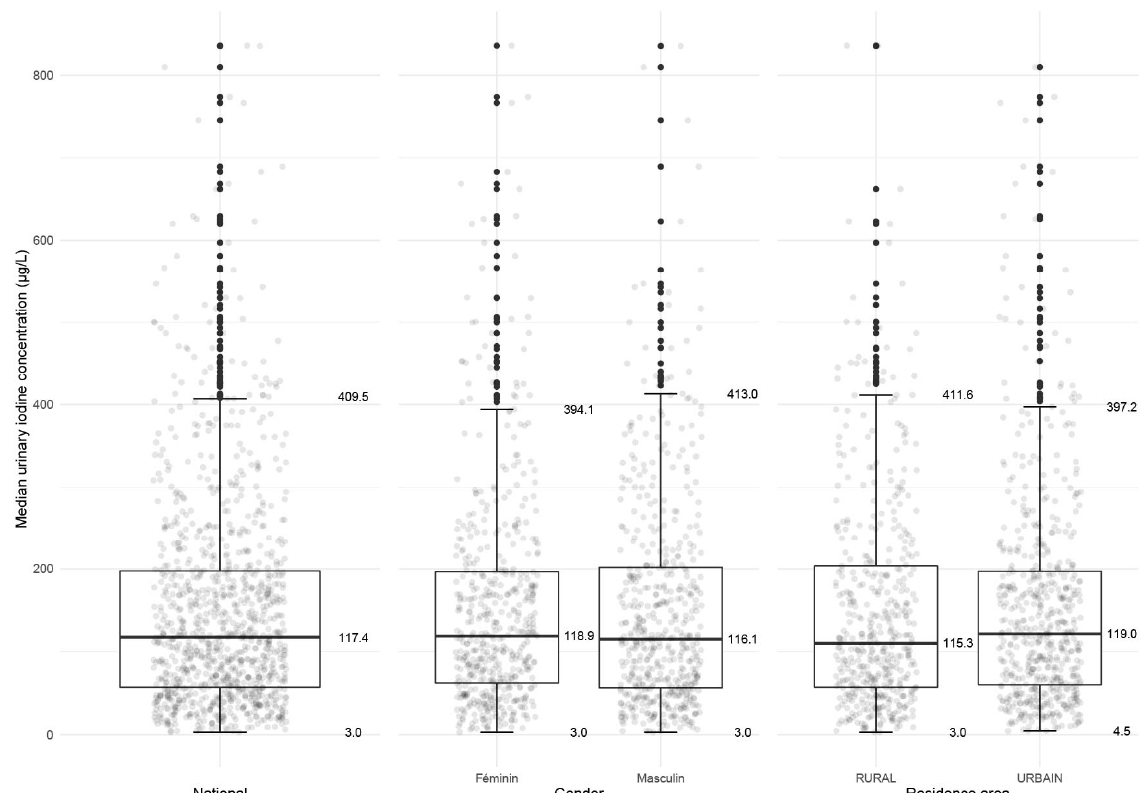
Figure 1. The median urinary iodine in all subjects by gender and residence area. There were no statistically significant differences in mUIC by gender: the mUIC (95% CI) in boys and girls was 116.1 µ g/L (107.3; 125.6) and 118.8 µ g/L (102.1; 128.5), respectively. There were no statistically significant differences in mUIC by urban vs. rural areas: the mUIC (95% CI) in urban and rural clusters was 119.0 µ g/L (109.9; 128.8) and 115.3 µ g/L (102.1; 123.3),